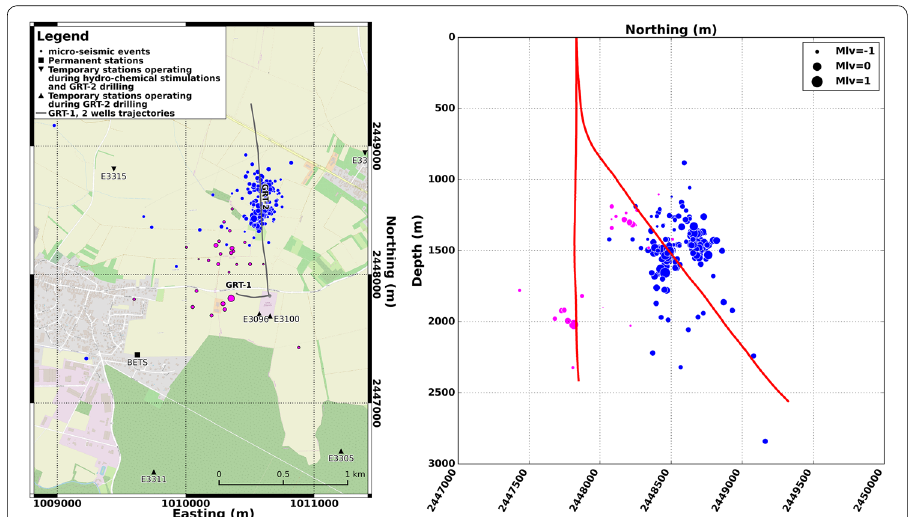
Fig. 6 Epicenter map (left) and South–North vertical projection (right) of the seismicity recorded during the GRT-1 drilling (magenta circles) and GRT-2 drilling (blue circles)